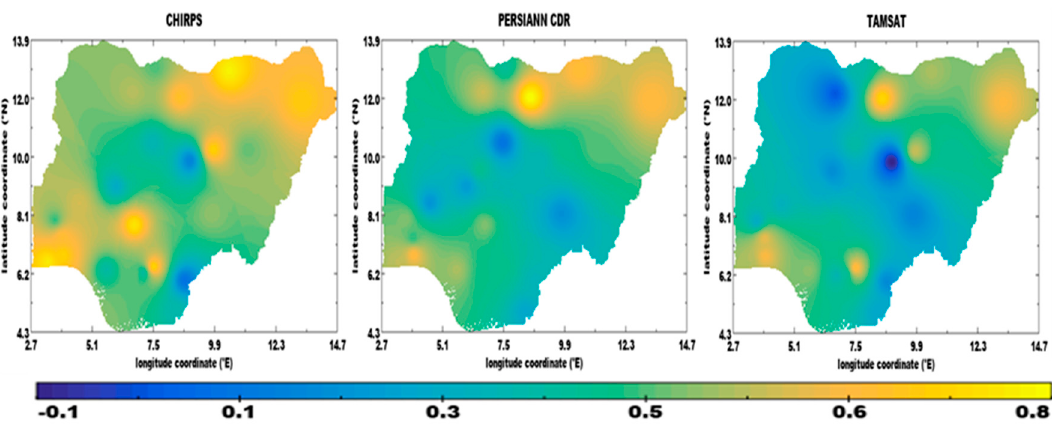
Climate 2020 , 8 , x FOR PEER REVIEW ffi cient of Mean JJAS Rainfall. Figure 6. Correlation Coefficient of Mean JJAS Rainfall. Figure 6. Correlation Coe